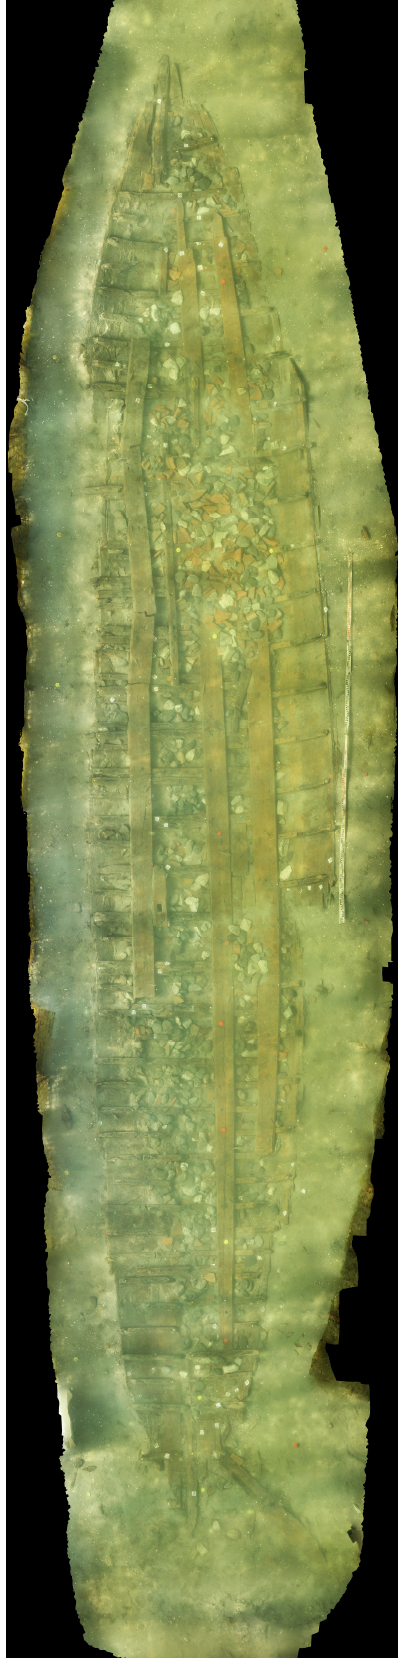
Figure 5. Orthophoto mosaic of the Phanagorian ship.